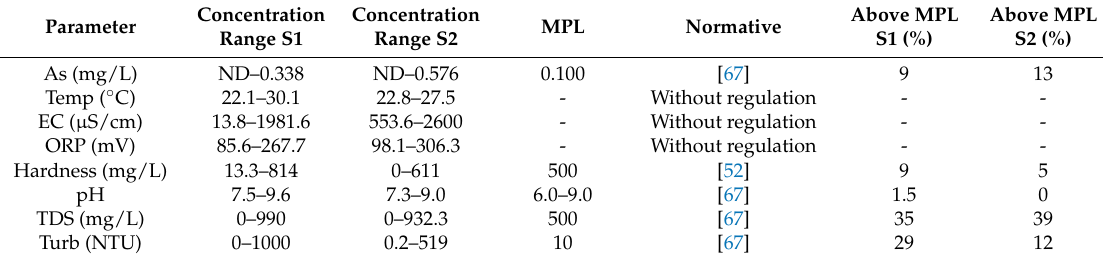
Table 2. Range of PhP concentrations, maximum permissible levels and percentage of samples that exceed